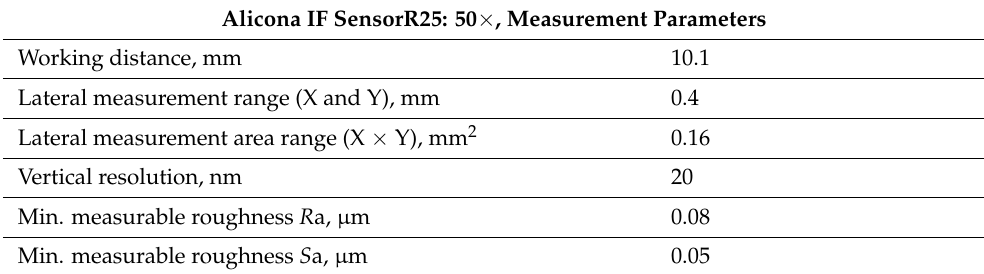
Table 3. Surface texture analysis parameters obtained by Alicona IF SensorR25: 50 × . Alicona IF SensorR25: 50 × , Measurement Parameters